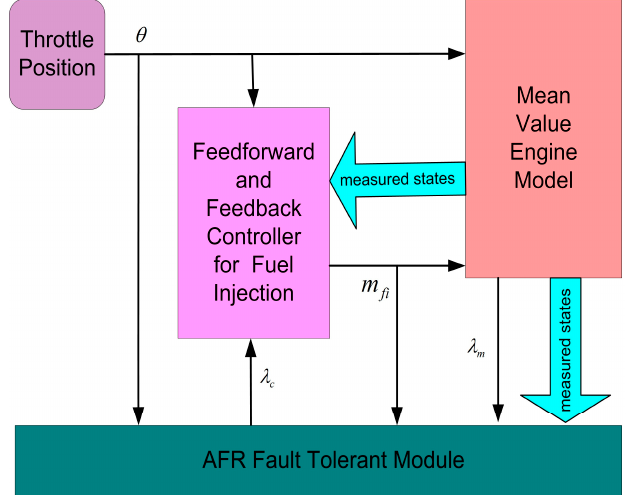
Figure 9. Fault-tolerant control strategy of the AFR.